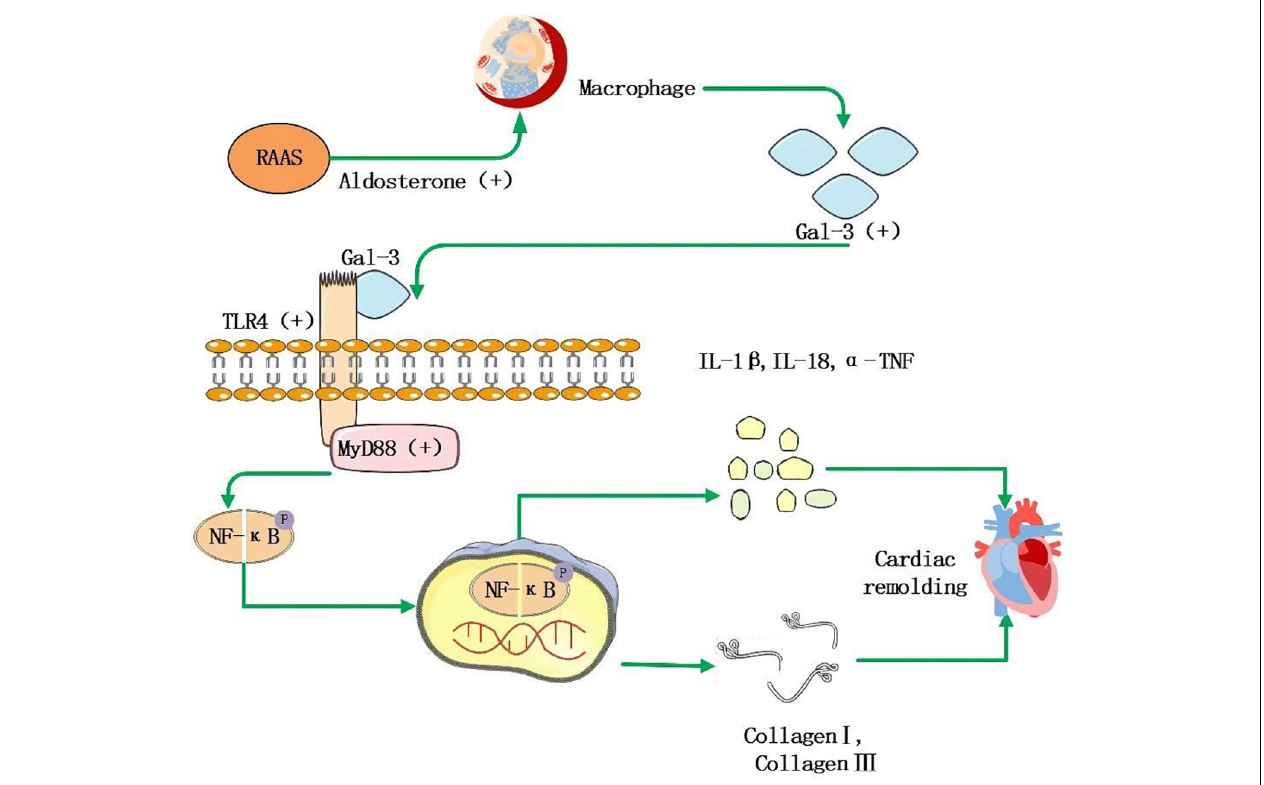
FIGURE 2 | RAAS system activation leads to increased secretion of aldosterone, which stimulates macrophages to secrete increased amounts of Gal-3, and it acts as a ligand to bind to TLR-4, further activating downstream MyD88, NF- κ B signaling pathway that facilitates the increase of inflammatory factor IL-1 β , IL-18, α -TNF, and collagen I, collagen III, then leads to myocardial remodeling and fibrosis.